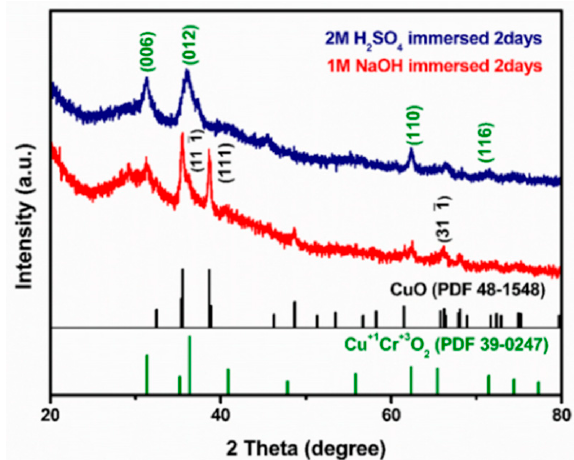
Figure 6. XRD patterns of Al 2 O 3 microfibers with copper chromium oxide deposited on the surfaces